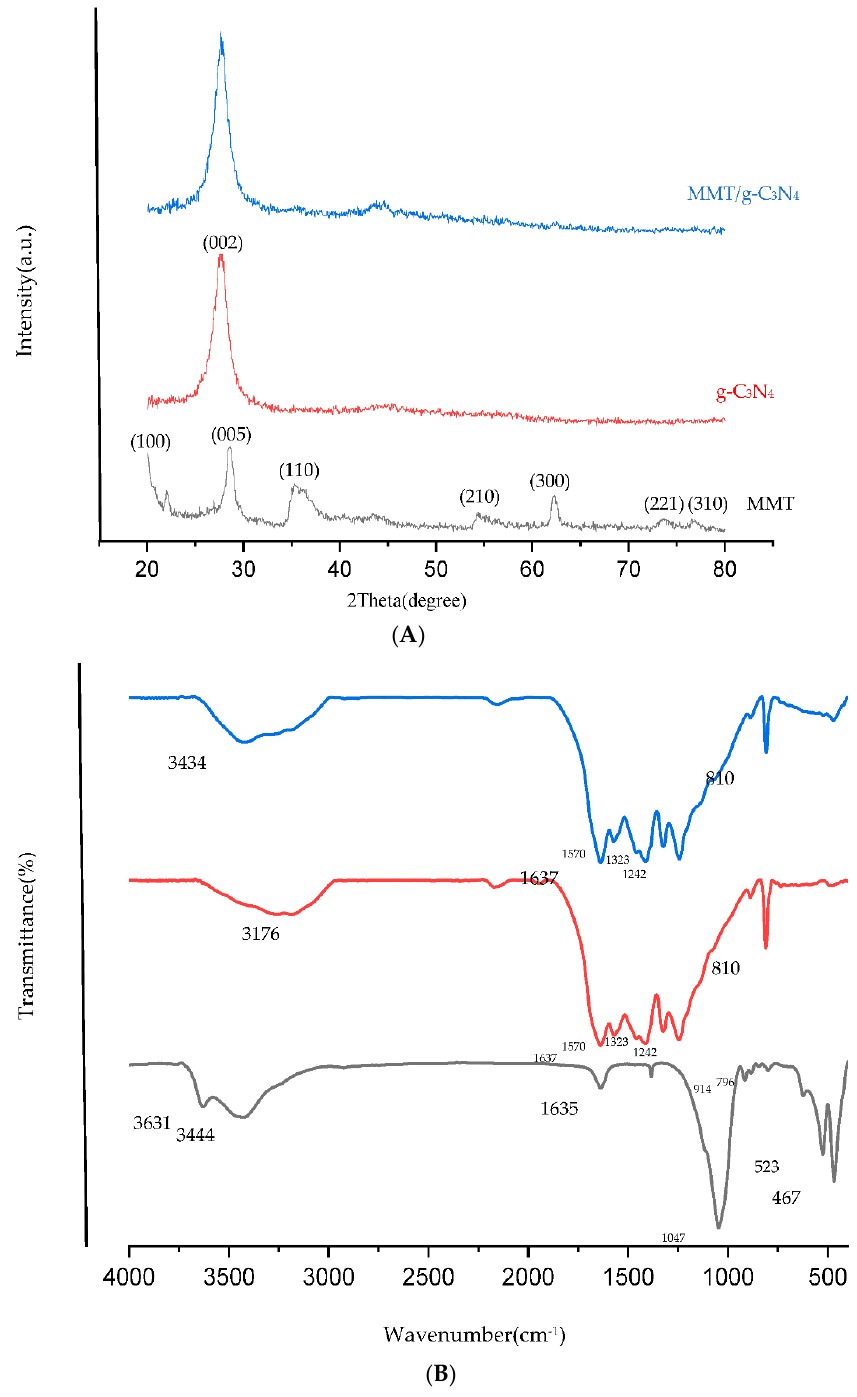
Figure 2. ( A ) The XRD patterns of the MMT, g-C 3 N 4 and MMT/g-C 3 N 4 and ( B ) the FTIR spectroscopy of the MMT, g-C 3 N 4 and MMT/g-C 3 N 4 .